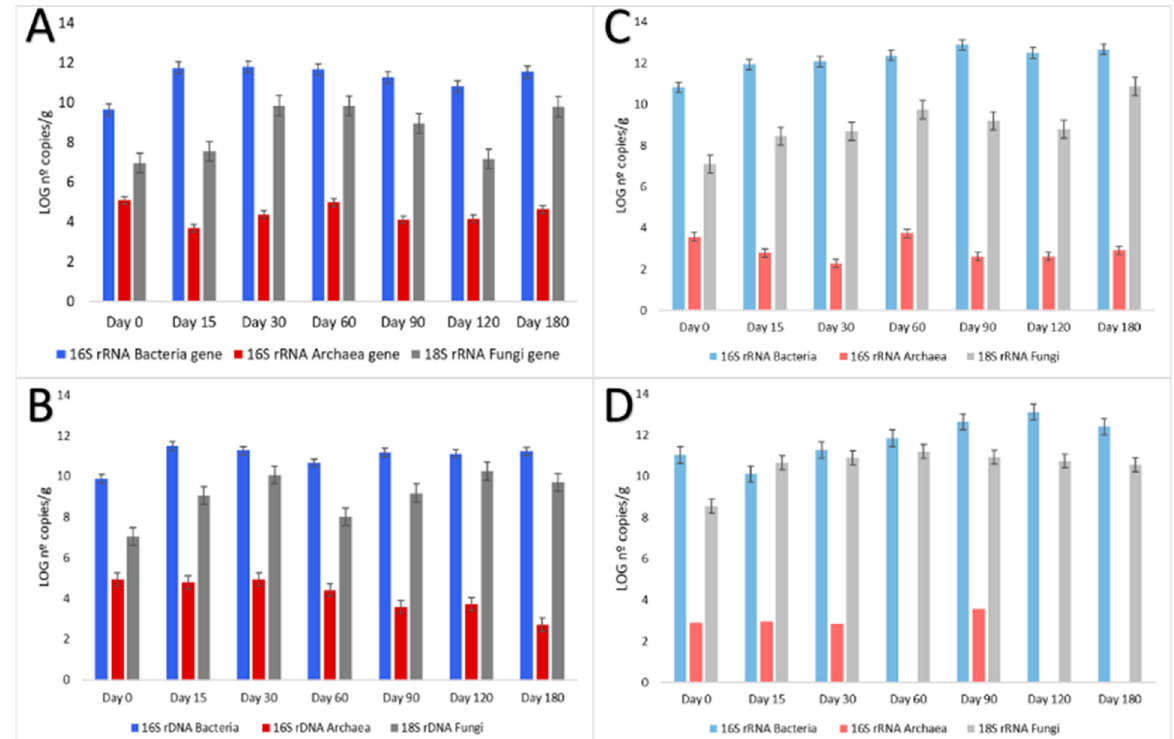
Figure 5. Number of copies of 16S rRNA gene of bacteria and archaea, and 18S rRNA gene of fungi per gram of granular biomass of the control bioreactor during the whole experimental period ( A ); number of copies of 16S rRNA gene of bacteria and archaea, and 18S rRNA gene fungi per gram of granular biomass of bioreactor amended with pharmaceutical compounds during the whole experimental period ( B ); number of copies of 16S rRNA of bacteria and archaea, and 18S rRNA fungi per gram of granular biomass of the control bioreactor during the whole experimental period ( C ); number of copies of 16S rRNA of bacteria and archaea, and 18S rRNA fungi per gram of granular biomass of bioreactor amended with pharmaceutical compounds during the whole experimental period ( D ).